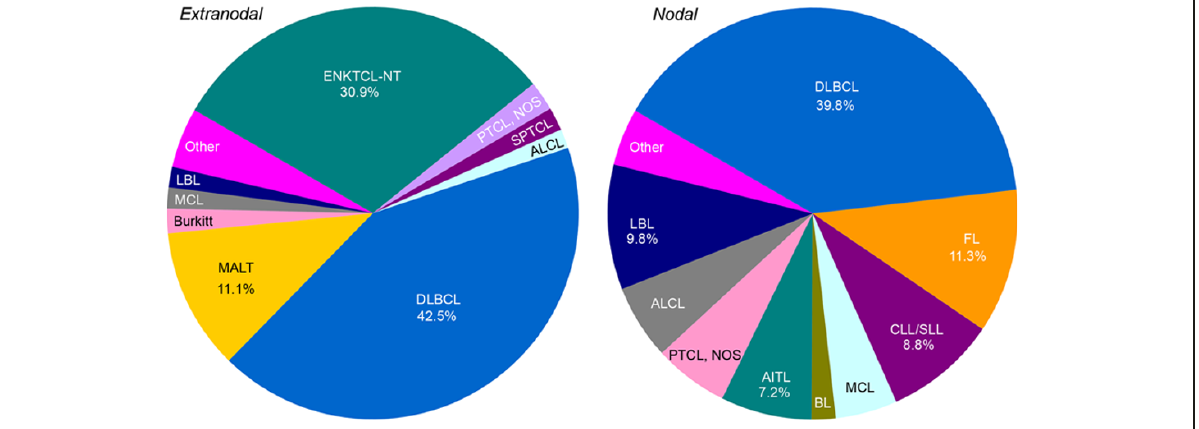
Figure 2 Distribution of histological subtypes in extranodal and nodal lymphoma